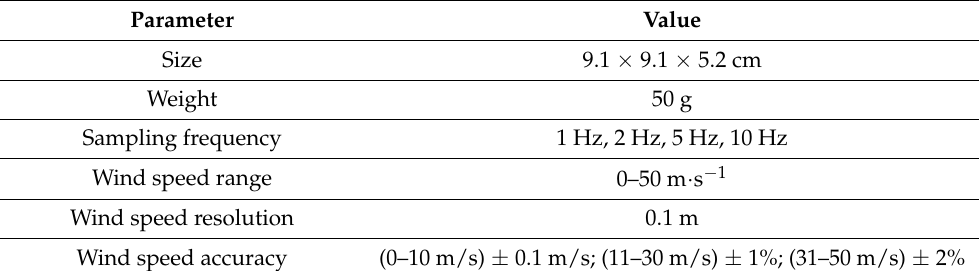
Table 2. TriSonica TM sonic anemometer technical